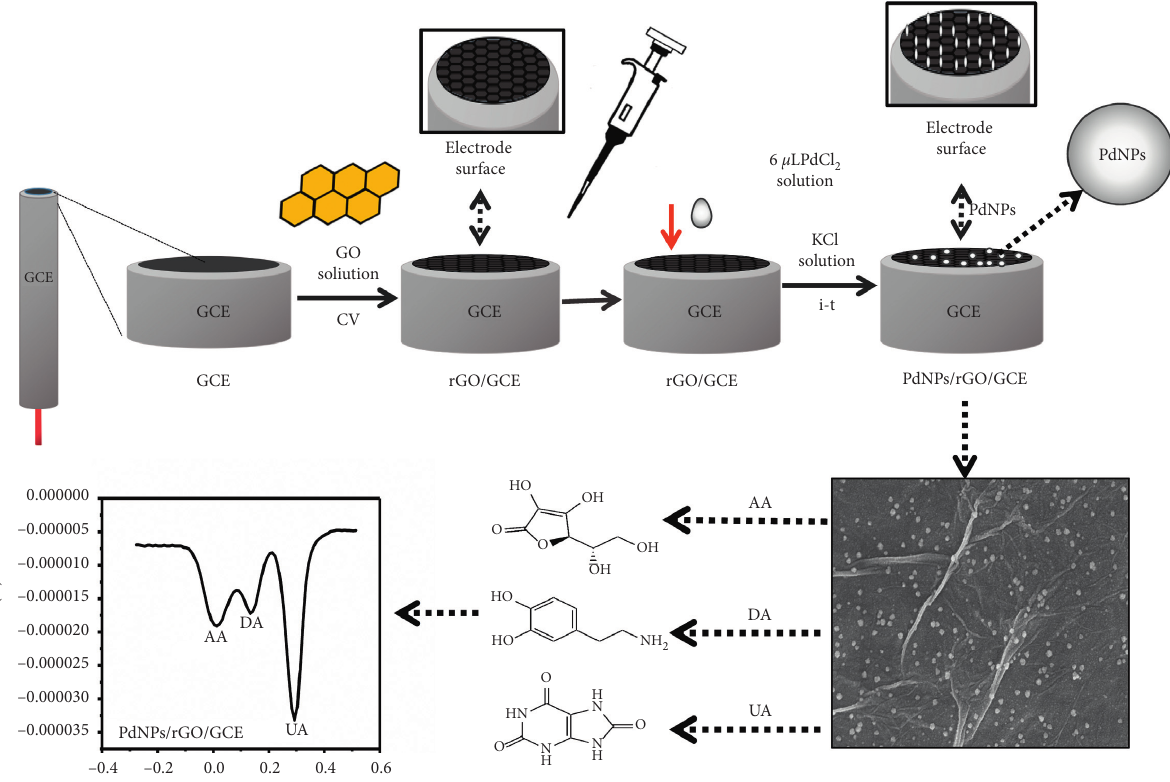
Scheme 1: Steps for fabrication of